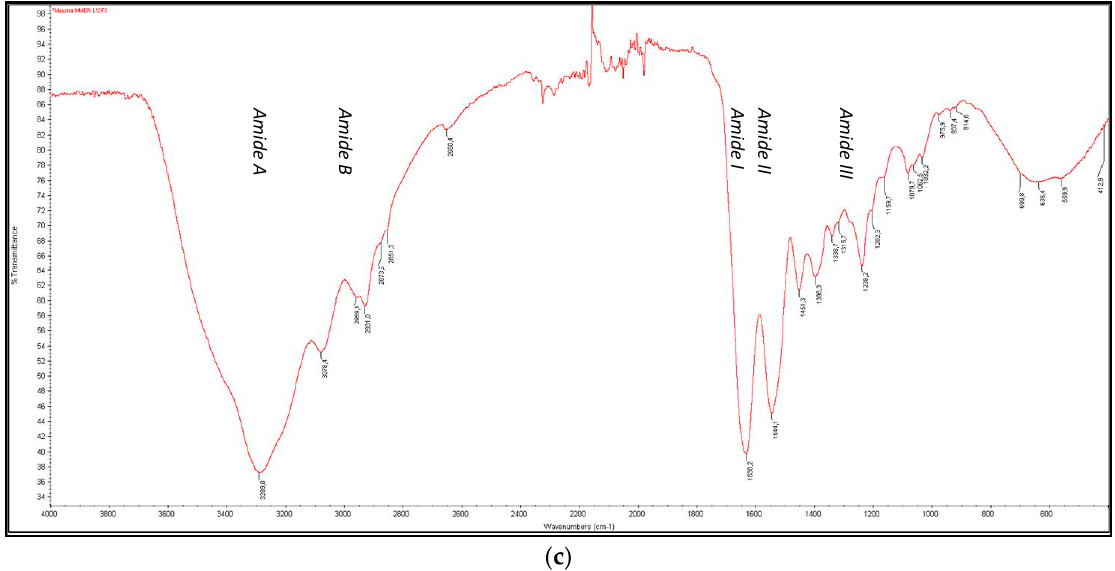
Figure 7. Fourier ‐ transform infrared (FTIR) spectra of F1, F2, and F3 ( a , b , and c , respectively) of collagen from skin hake.